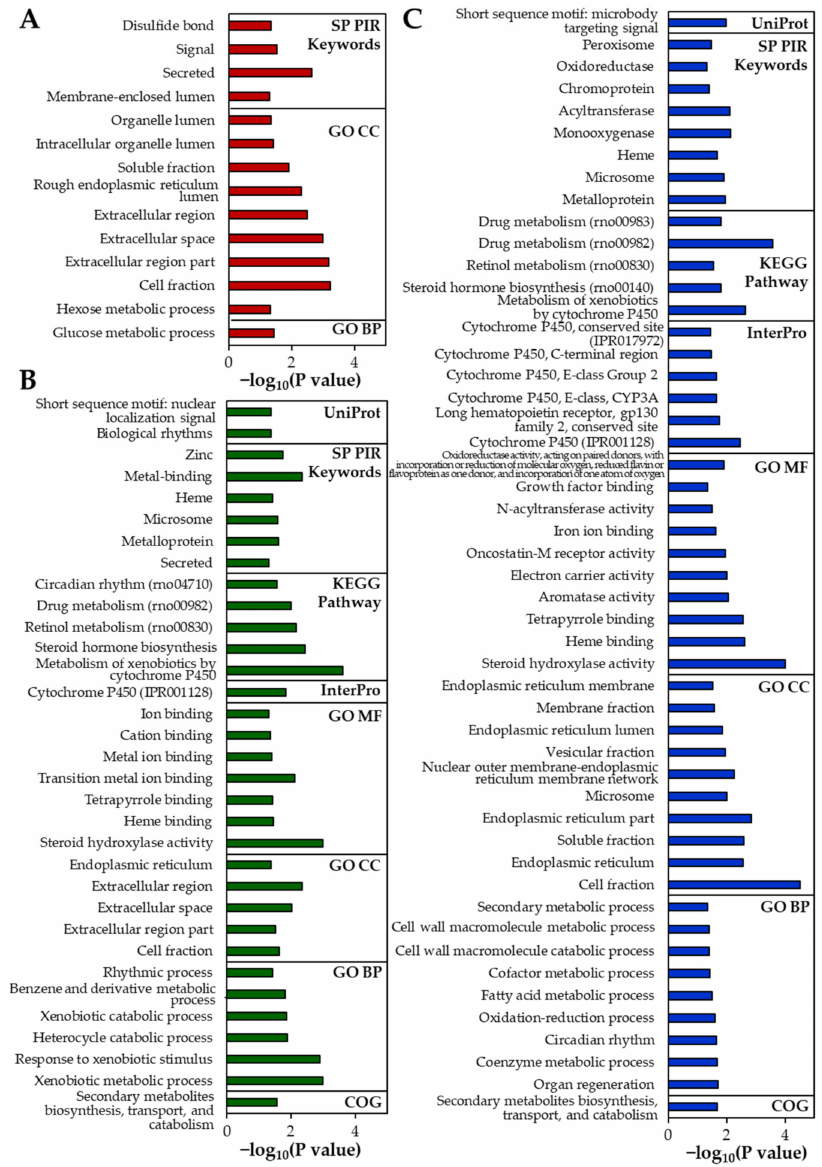
Figure 6. Gene enrichment analysis of the differentially expressed genes (DEGs) in the rat livers using Database for Annotation, Visualization, and Integrated Discovery (DAVID) tools after 14-day repeated oral administration of ( A ) B-ZnO, ( B ) N-ZnO or ( C ) Zn ions in rats. The significantly enriched terms are presented (modified Fisher Exact p < 0.05). SP PIR, Swiss-Prot and Protein Information Resource; KEGG, Kyoto encyclopedia of genes and genomes; GO, Gene Ontology; BP, Biological Process; CC, Cellular Component; MF, Molecular Function; COG, Cluster of Orthologous